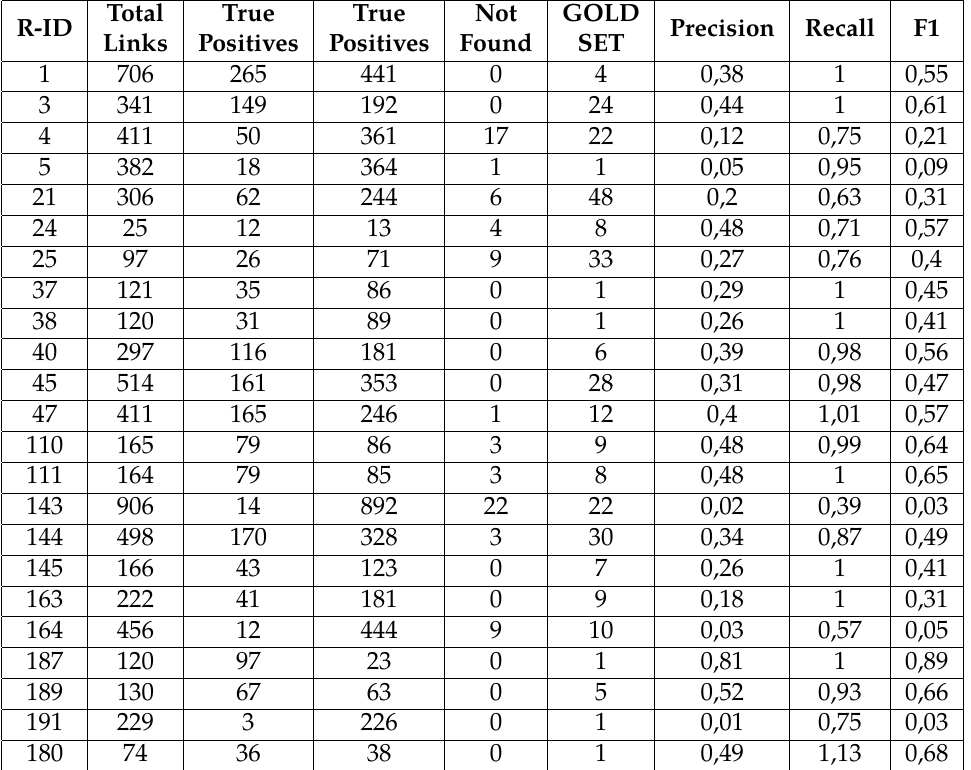
Table 5: FGTHunter results for iTrust requirements.